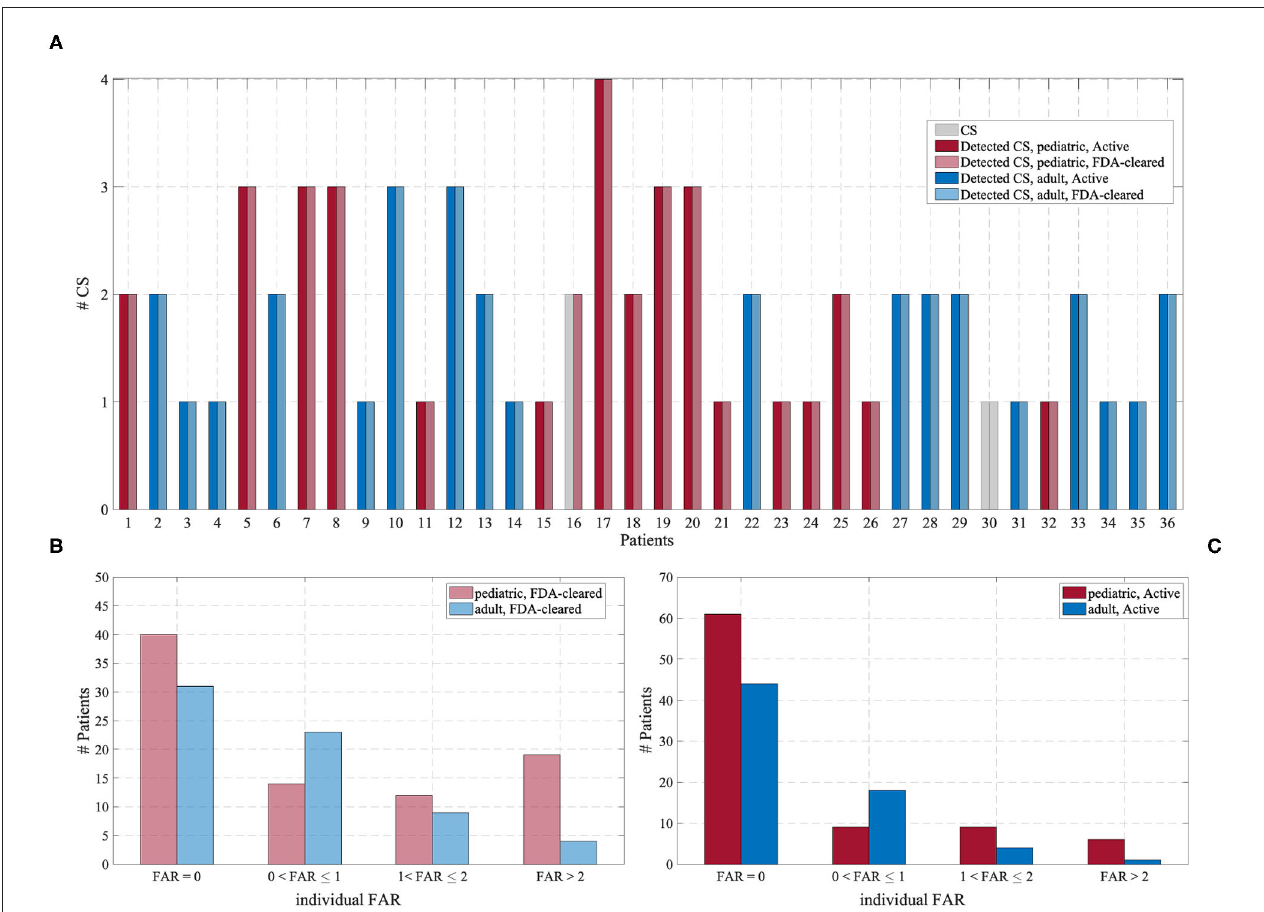
FIGURE 4 | (A) Number of CS (gray) and the number of detected CS for each of the 36 patients experiencing CS, grouped according to the operating point of the Detection Algorithm and the age group. (B) Distribution of the individual FAR for the “FDA-cleared” mode. (C) Distribution of the individual FAR for the “Active”